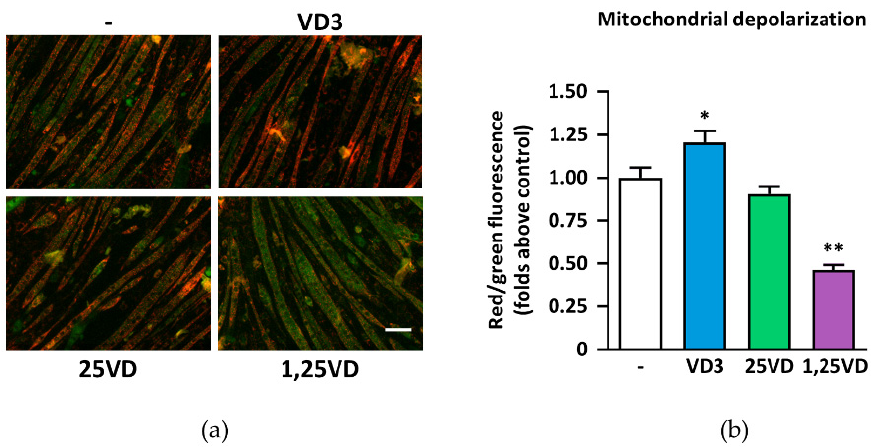
Figure 1. Mitochondrial membrane depolarization induced by 1,25VD. ( a ) Representative images of fluorescence of JC-1 in C2C12 myotubes treated with 100 nM cholecalciferol (VD3), 25-hydroxyvitamin D3 (25VD), or 1,25-dihydroxyvitamin D3 (1,25VD) for 24 h in serum-free medium, scale bar 100 μ m; ( b ) Quantification of the ratio of red/green fluorescence in treated cells compared to vehicle-treated controls. Data are presented as means ± SEM of three independent experiments; * p < 0.05; ** p < 0.01 compared to vehicle-treated cells.